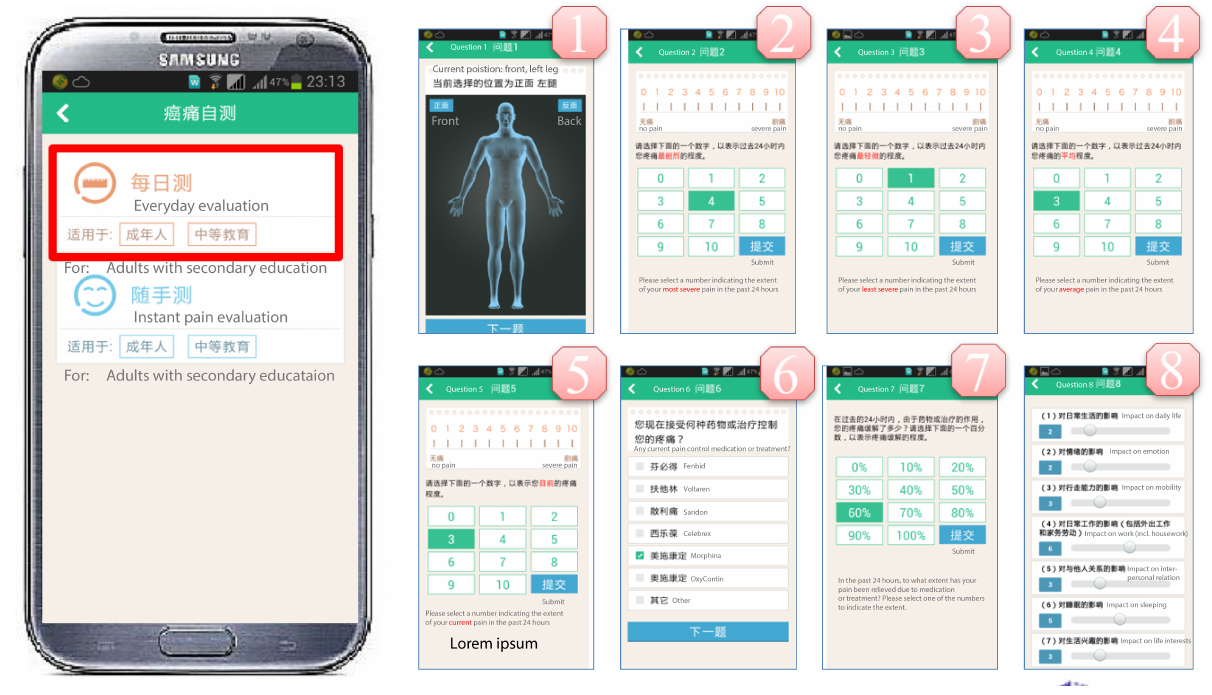
Figure 4. Screenshots of daily pain assess sub-module in cancer-pain self-evaluation module.